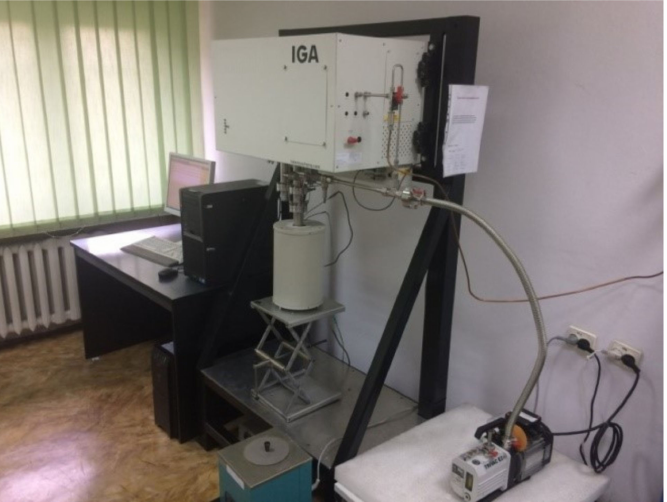
Figure 5. IGA-001 gravimetric sorption system used to investigate methane sorption kinetics and methane sorption